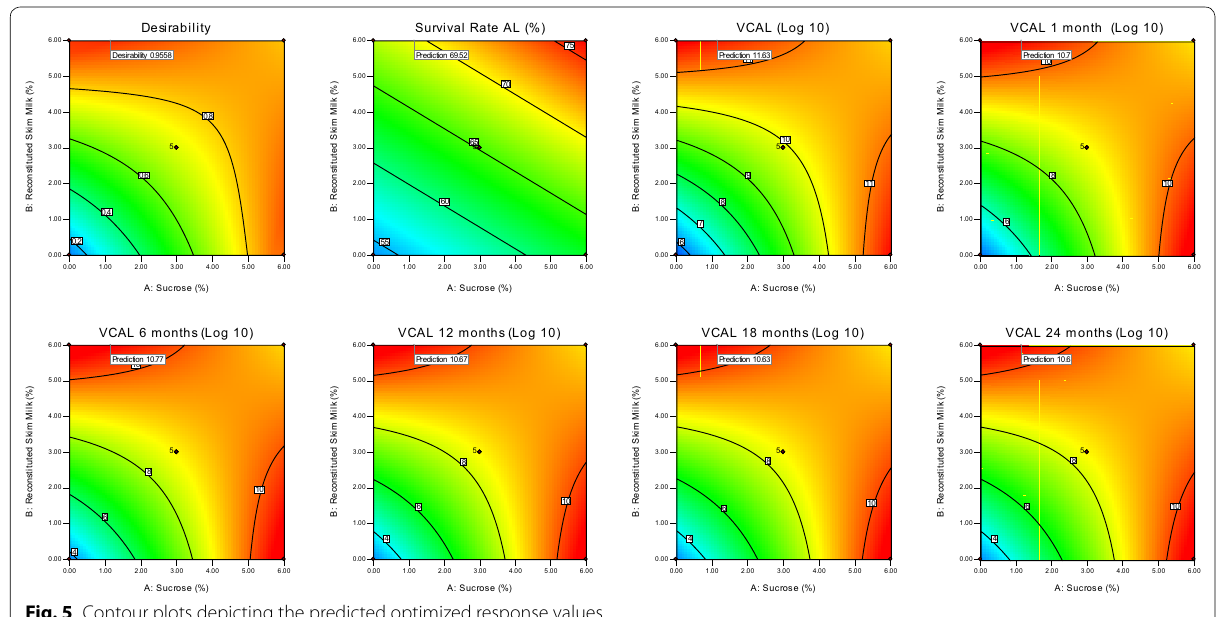
Fig. 5 Contour plots depicting the predicted optimized response values